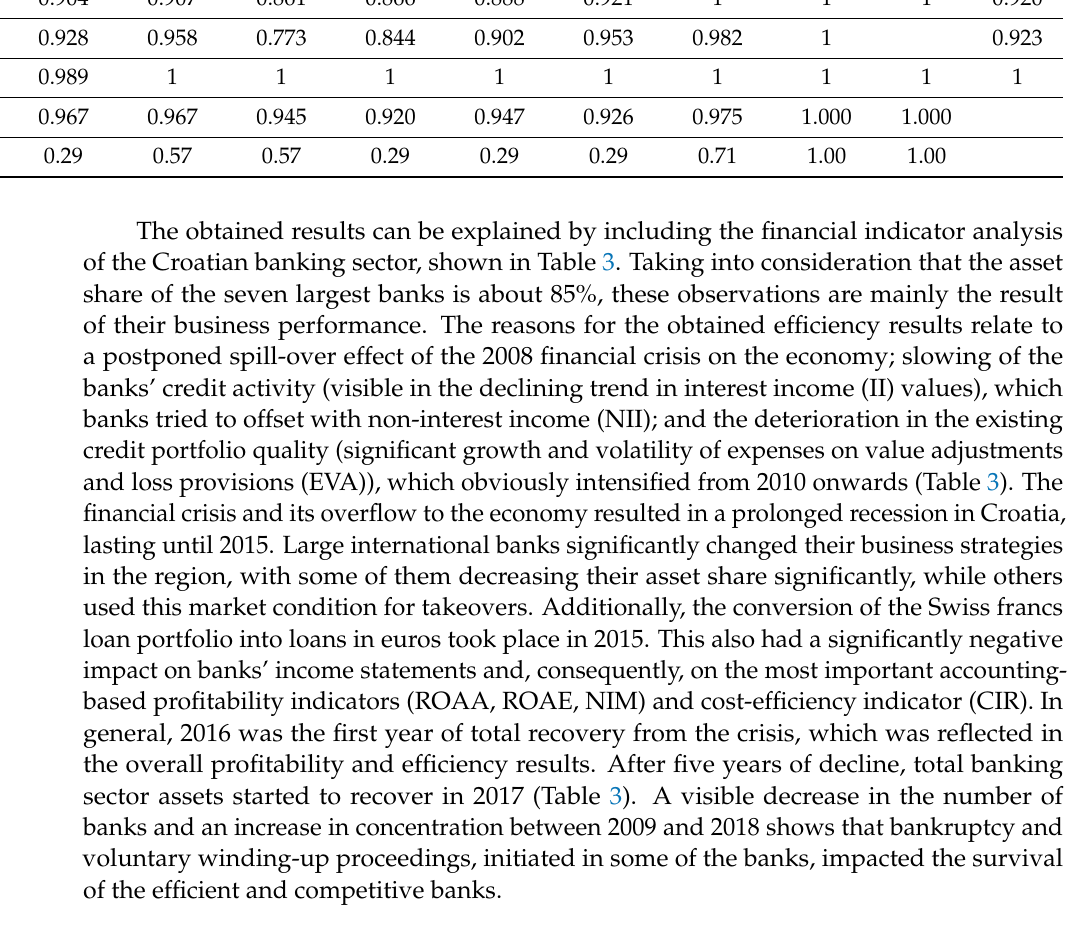
Table 3. Croatian banking sector business performance indicators, 2009–2018